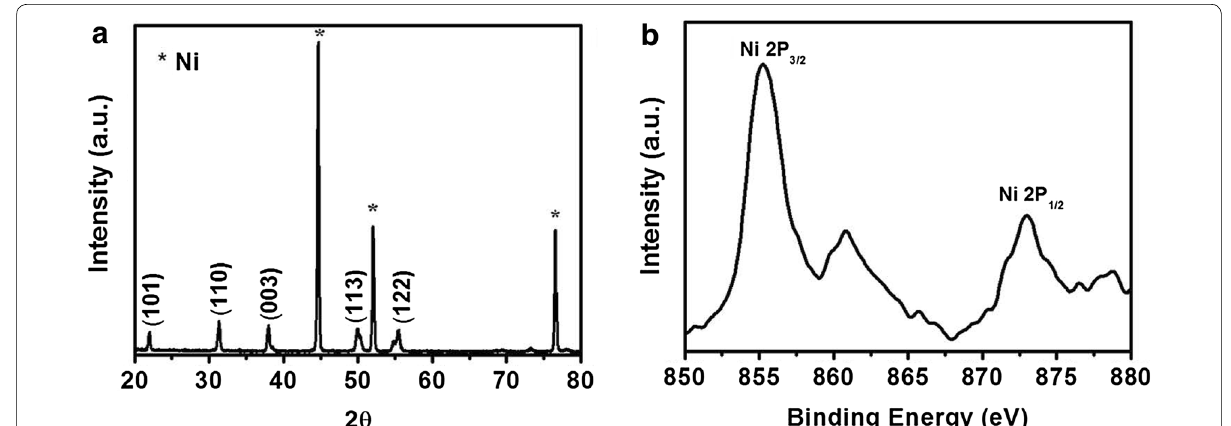
Fig. 3 a X-Ray diffraction and b XPS spectra of the SW Ni–Ni 3 S 2